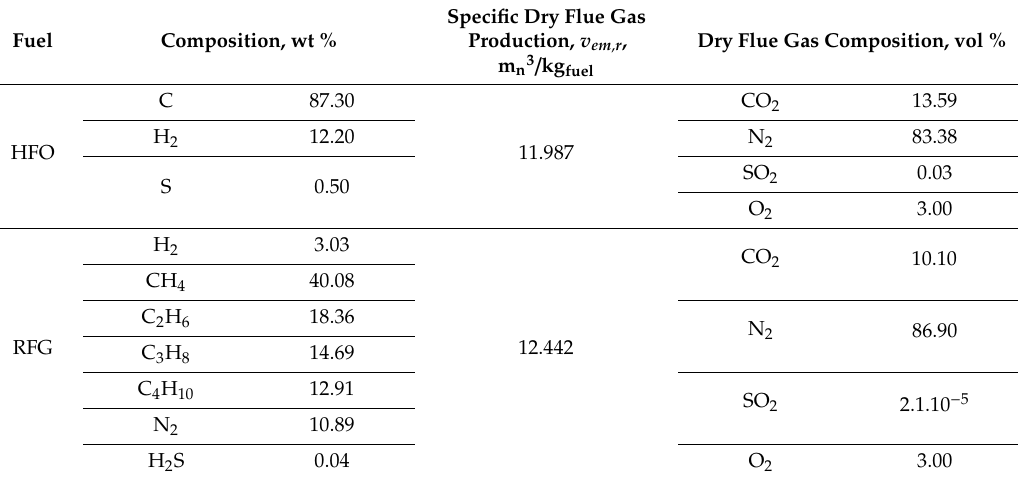
Table 6. Results of fuel combustion material balance.